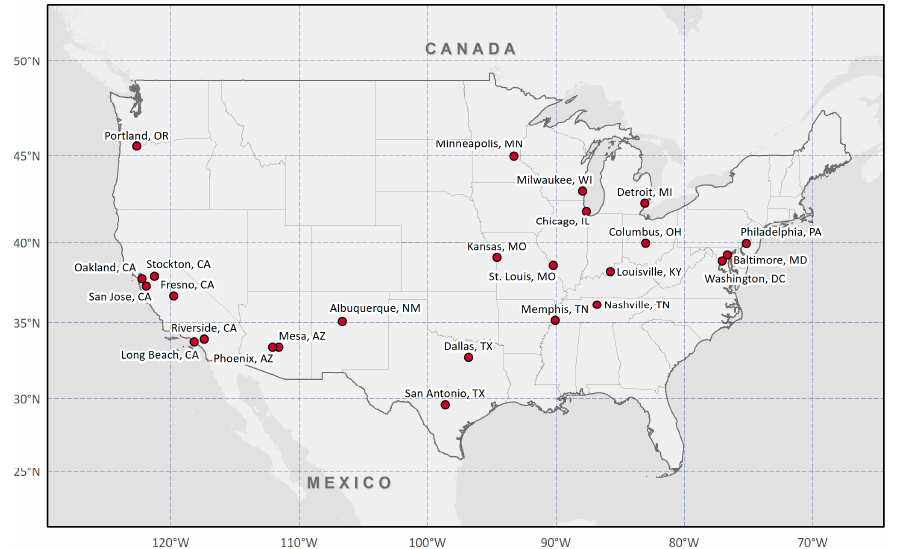
Figure 1. Twenty-five cities included in the analysis based on official data availability and population